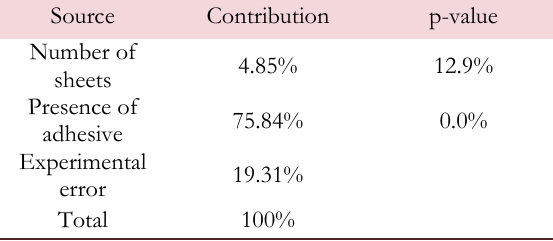
Table 1: ILSS value measured for all the tested